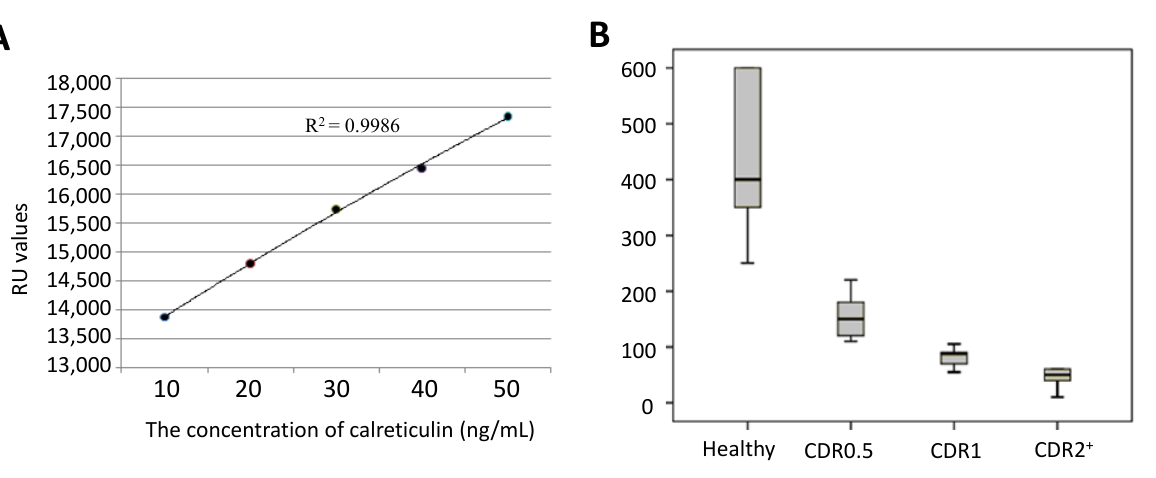
Figure 2. Measurement of serum calreticulin using ELISA. ( A ) A standard curve was plotted between the concentration of calreticulin and absorbing value at 450 nm and ( B ) A bar diagram shows the differences in serum levels of calreticulin among AD patients with different Clinical Dementia Rating (CDR)